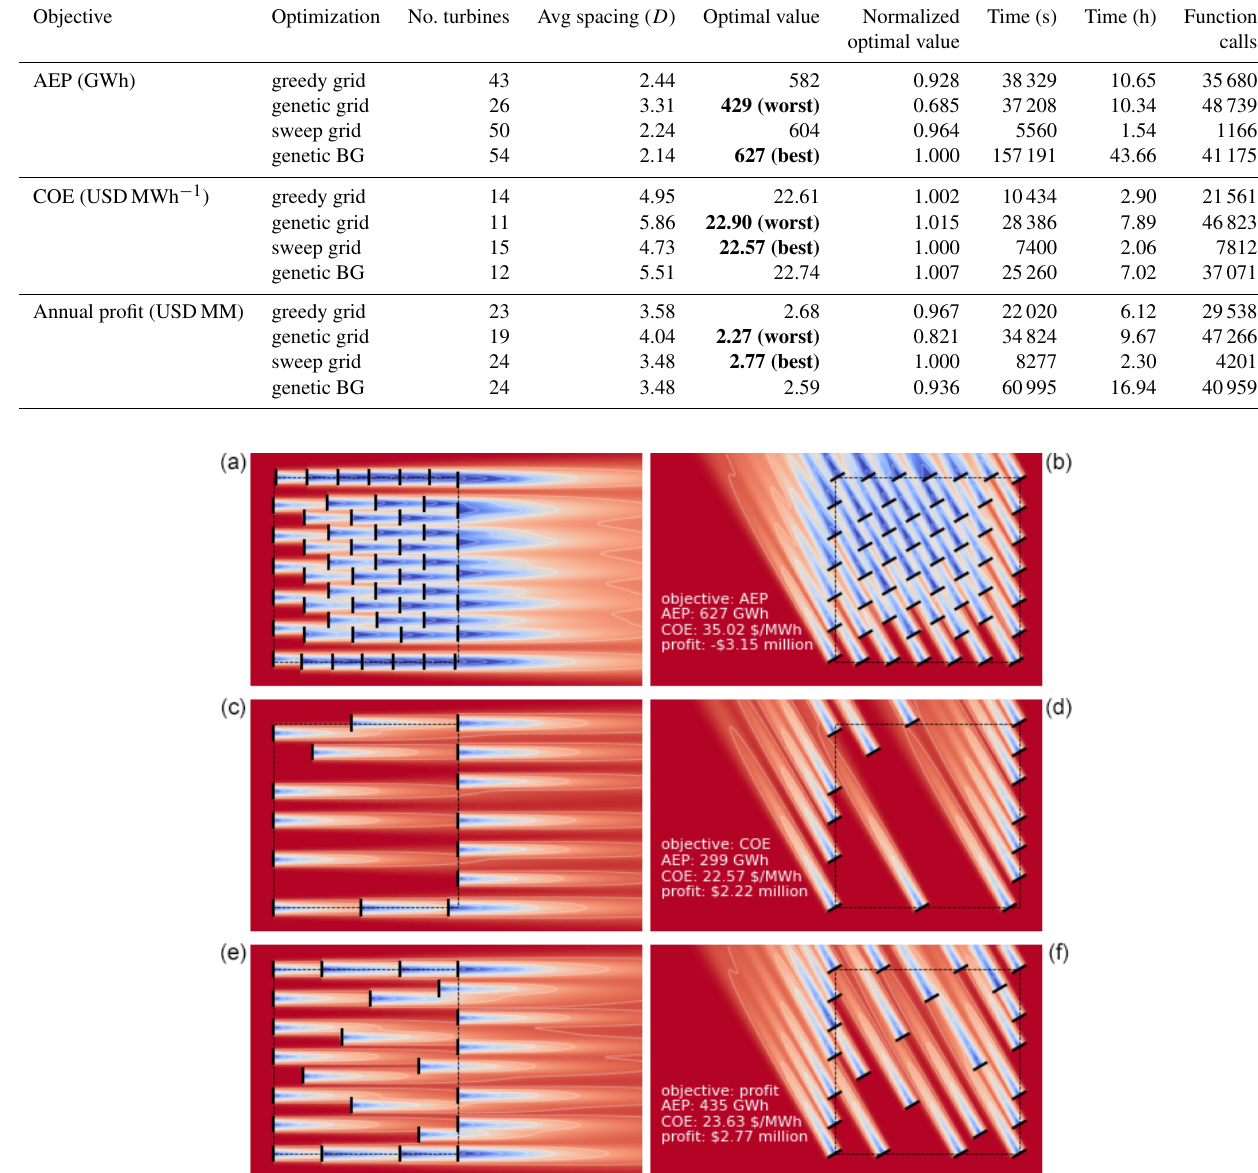
Figure 12. The optimal layouts for each objective for the large wind power plant with a full wind rose. From top to bottom, the associated objective functions are AEP, COE, and profit. The text within each figure provides the value of all three metrics for each wind plant. The two columns represent the flow field for each objective from the two dominant wind